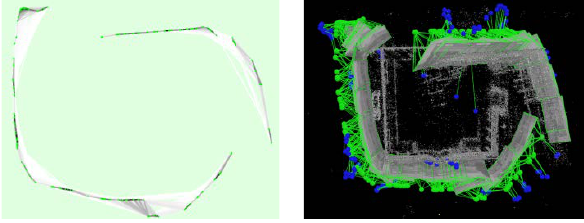
Figure 13: non-connected terrestrial image-block, Wallis- filtered